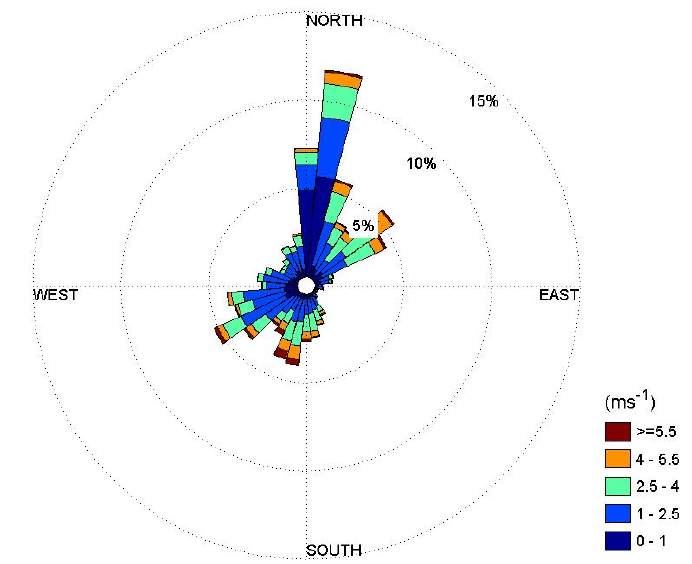
Figure 1. Annual wind-rose measured in Gwangju in 2011.